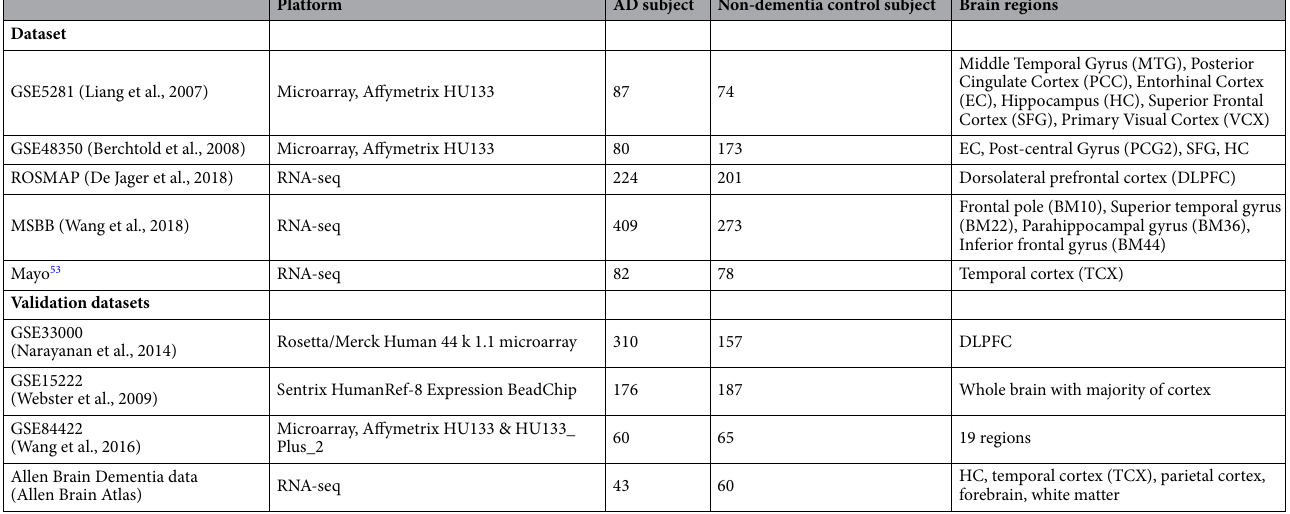
Table 1. Summary of AD and non-dementia control brain transcriptomic datasets used in this